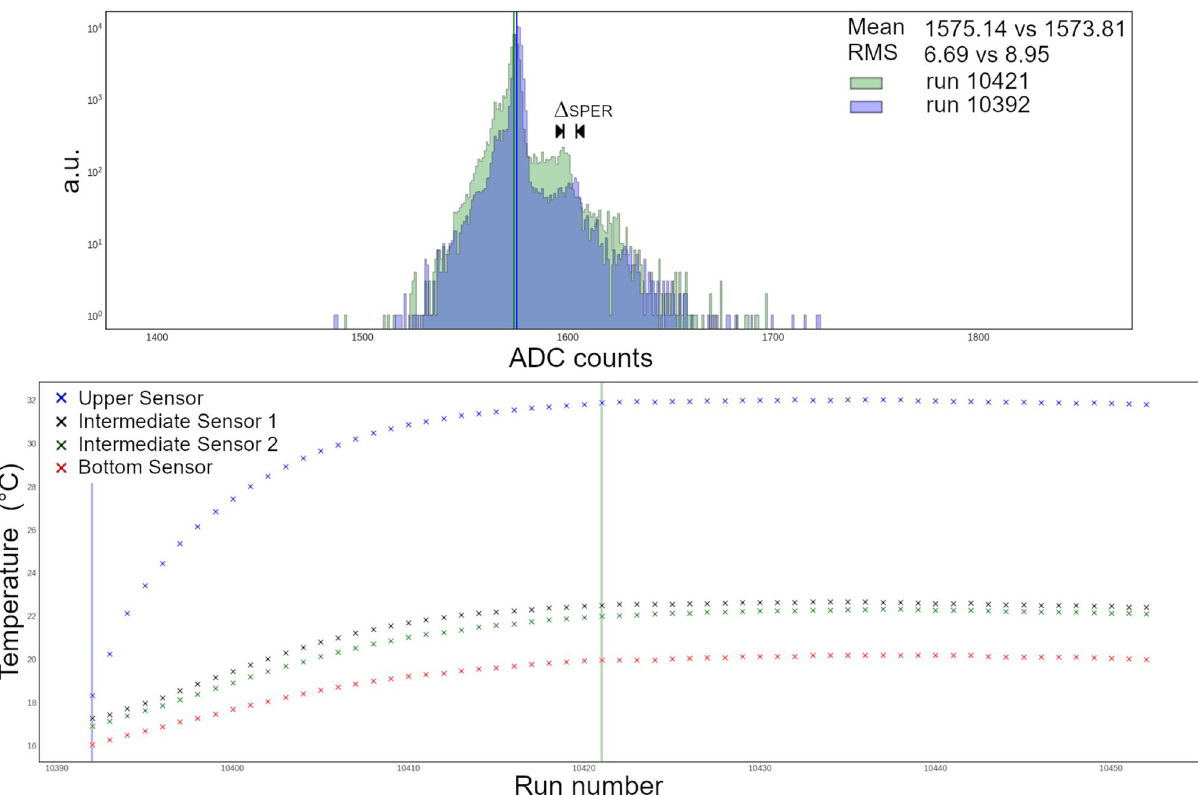
Figure 5. Comparison of two dark noise spectra of a SiPM. The blue spectrum refers to the first test run and the green spectrum to a run in which the temperature curves inside the stainless steel shell have reached the plateau. The increase in temperature inside the detector shell due to overheating of the electronics causes a slight increase in RMS together with a peak value variation of the first photoelectron ( (cid:31) SPER ). The incremental trend of temperatures was measured by four temperature sensors with the detector in vertical position. Temperatures stabilizes in 5–6 h and the room temperature varies slightly around 15.5